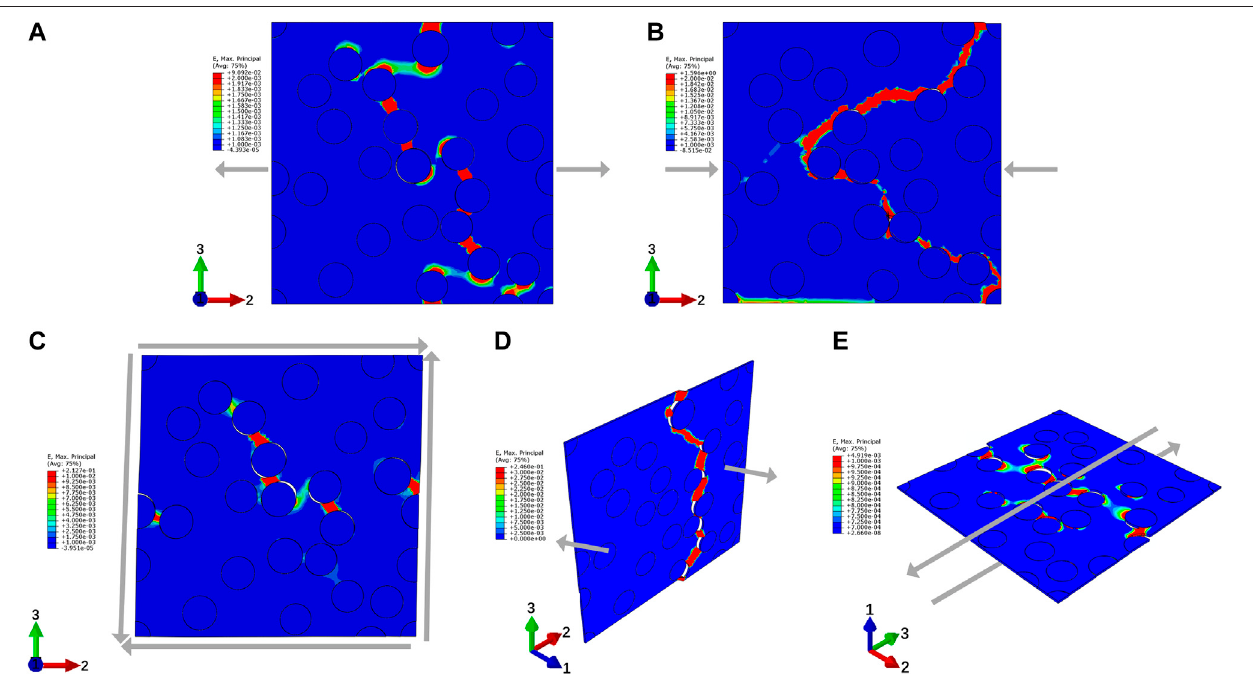
FIGURE 6 | Contour plots of the accumulated strain with different loading conditions when ceramic composite ( V f (cid:2) 28%) fails: (A) transverse tension, (B) transverse compression, (C) out-plane shear ( τ 21 ) with deformation magni fi ed by afactor of 10, (D) in-plane parallel shear ( τ 21 ) with deformation magni fi ed by a factor of 10, and (E) in-plane perpendicular shear ( τ 21 ) with deformation magni fi ed by a factor of 100.